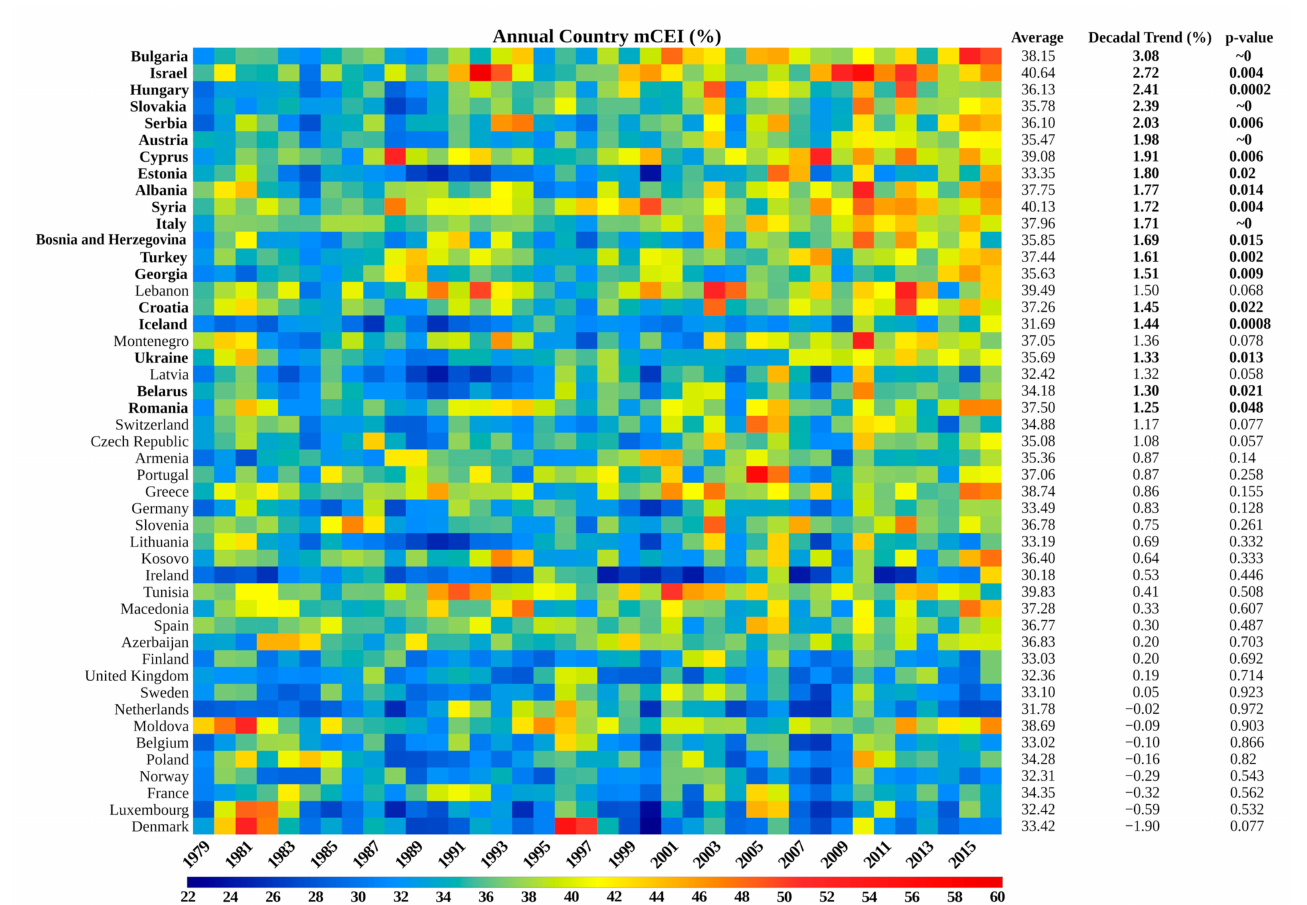
Figure 12. Country-based annual and climatological means, and decadal trends of mCEI. Boldface country name indicates a statistically significant trend at 95% confidence